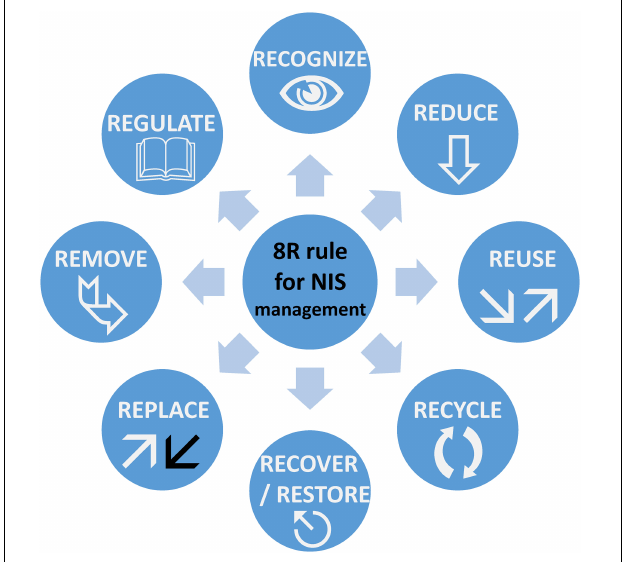
FIGURE 1 | Representation of the 8Rs model for NIS management. This model can be adapted for use for other sources of biological or chemical